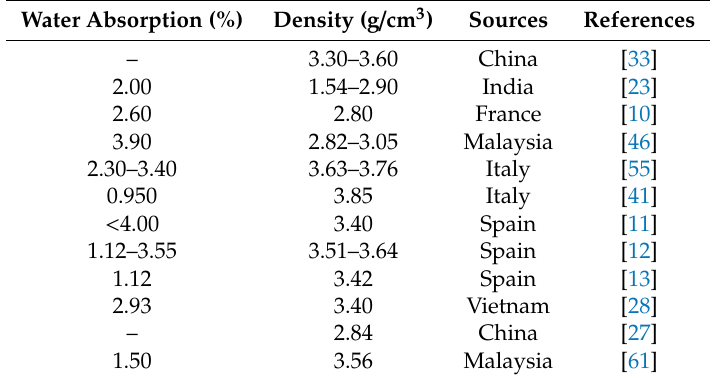
Figure 3. EAF slag samples from different countries. ( a ) Italy [56]; ( b ) Malaysia [60]; ( c ) China [27]; and ( d ) Spain [11]. Color variation of EAF steel slag is due to the different chemical compositions and oxidation conditions. Table 1. Water absorption and density of electric arc furnace (EAF) slag as reported in various